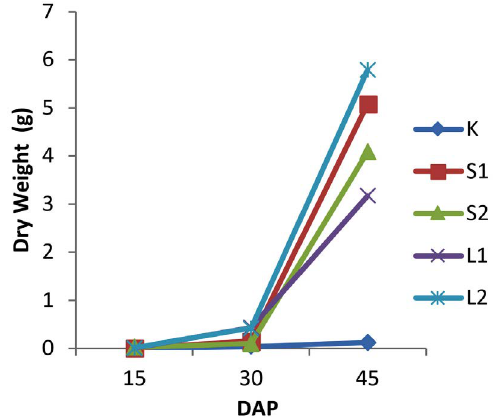
Fig. 2. Induced compost effect on the dry weight. K = control; S1 = Cellulolytic (10%); S2=Cellulolytic (20%); L1 = Ligninolytic (10%); L2 = Ligninolytic